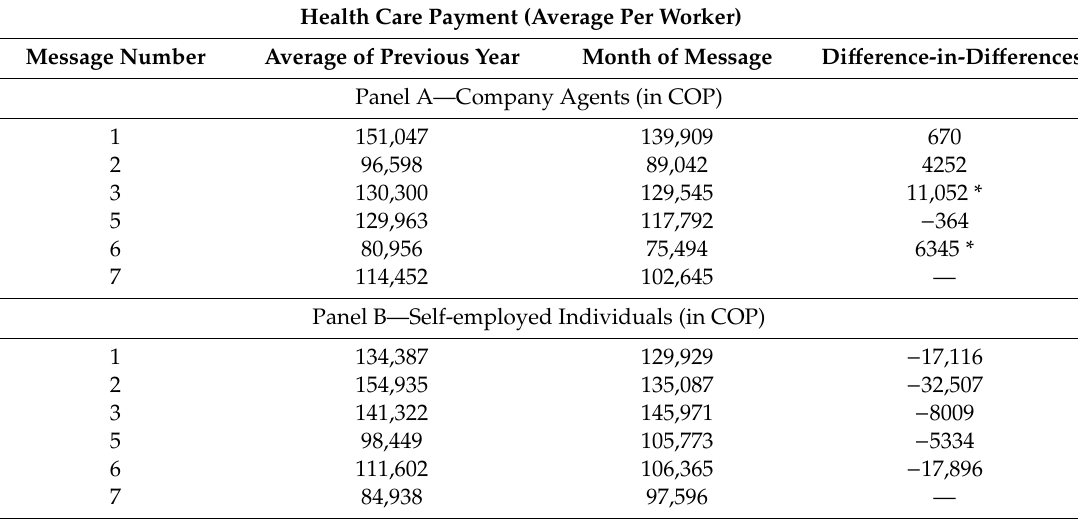
Table 3. Health Care Payments with “Neutral Message 7 as Control Group”— Pago Simple.